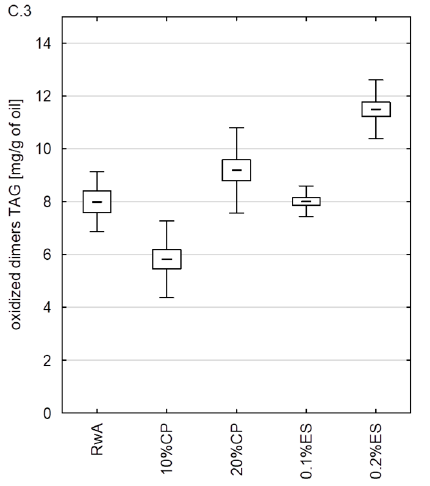
Figure 2. Products of thermal degradation of oils. Values are means of four determinations. ( A.1 , A.2 )—not heated samples; ( B.1 , B.2 )—samples heated at 170 °C; ( C.1 – C.3 )—samples heated at 200 °C; SE—standard error; SD—standard deviation.